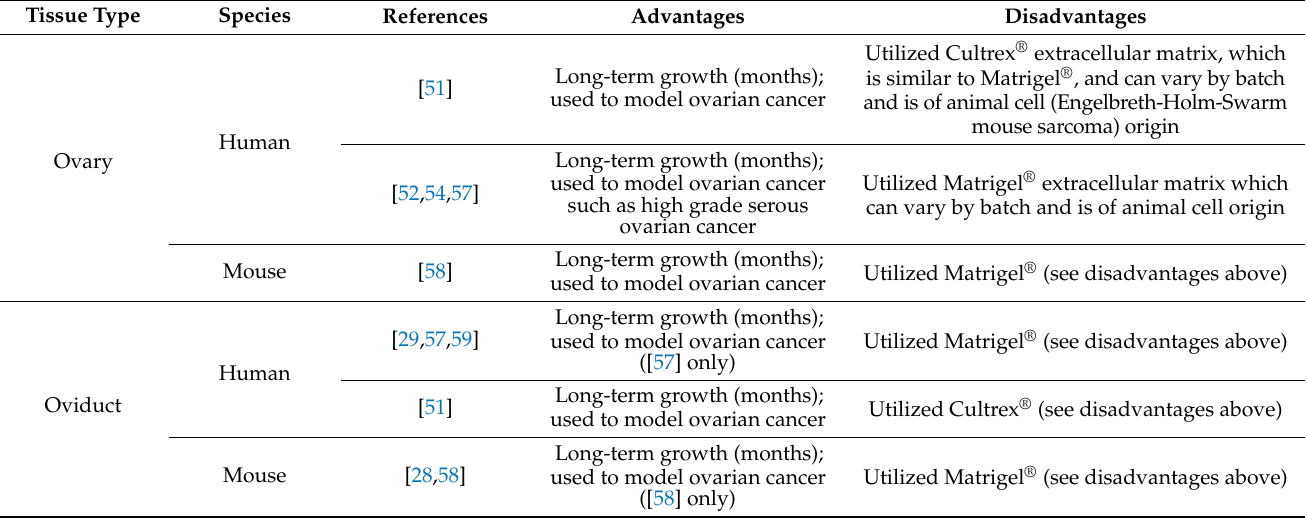
Table 2. Advantages and disadvantages of organoids derived from the female reproductive tract in humans, mice, and